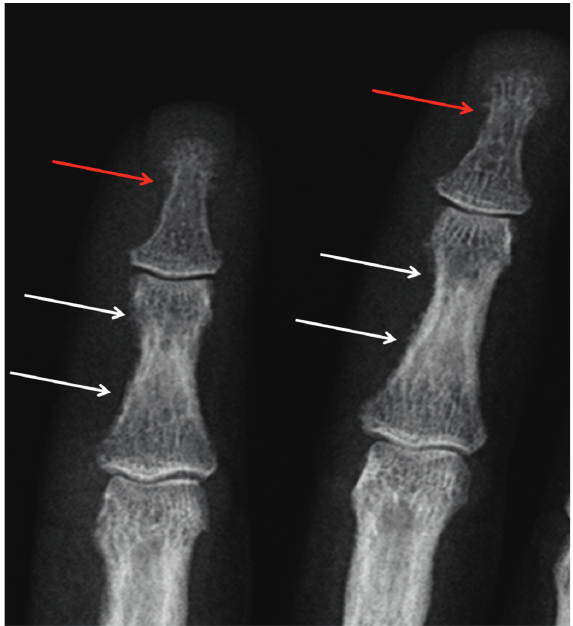
Figure 1: Subperiosteal resorption of the radial aspect of the middle phalanges of the second and third fingers (white arrows); feathery appearance and early tufts resorption-acroosteolysis (red